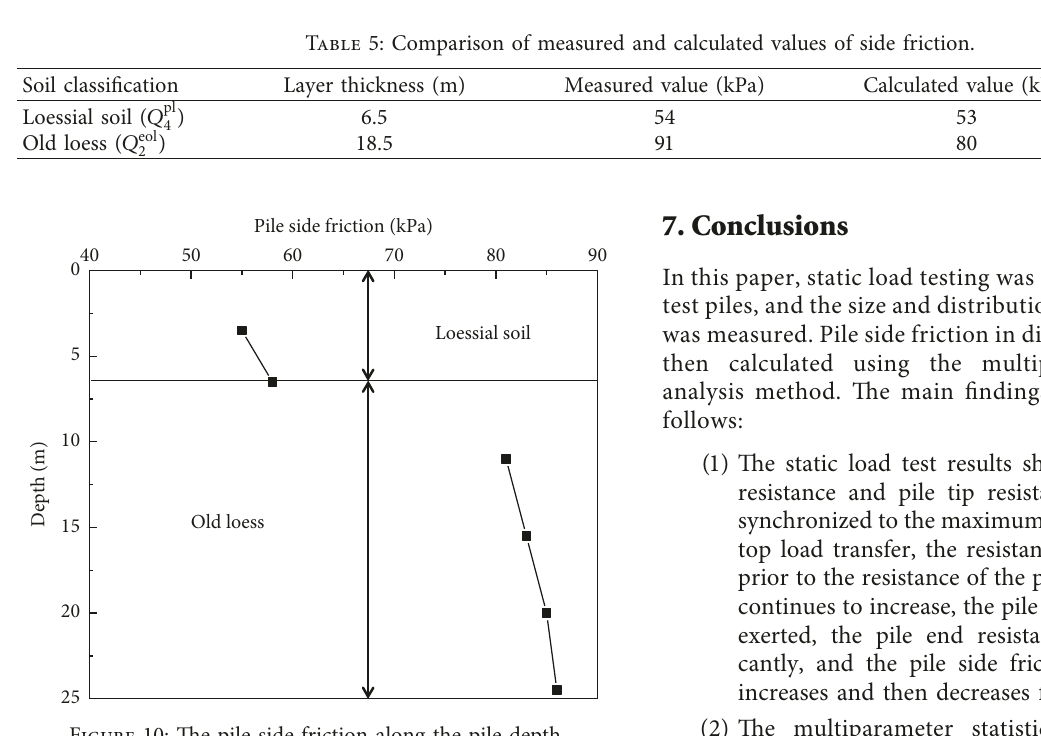
Figure 10: The pile side friction along the pile